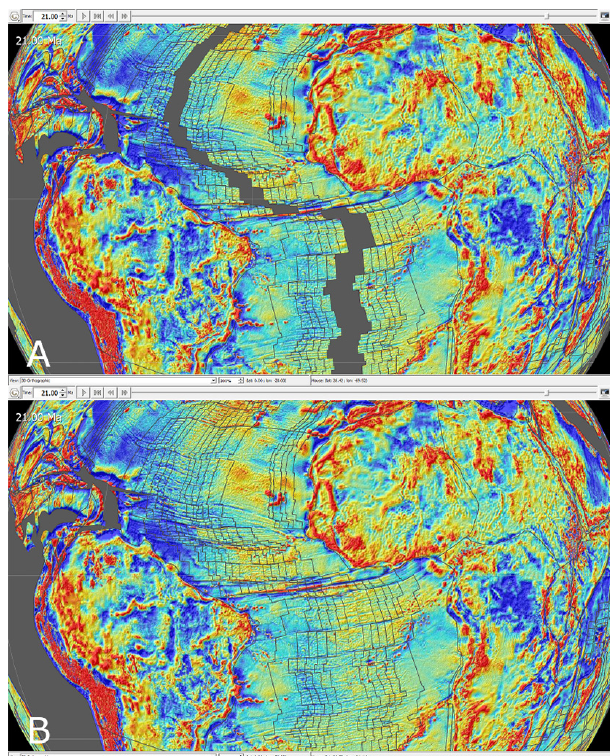
Figure 11. The global free-air gravity raster (Andersen et al., 2010), reconstructed to 21Ma. Overlaid on top is the static polygon data set (Seton et al., 2012) used to reconstruct the raster. Note the many long, thin oceanic polygons. (A) Reconstructed without using an age grid. The gap between Africa and South America is a result of the per-polygon age test. (B) Reconstructed using an age grid. The gap is no longer present because the age test is now per-pixel.